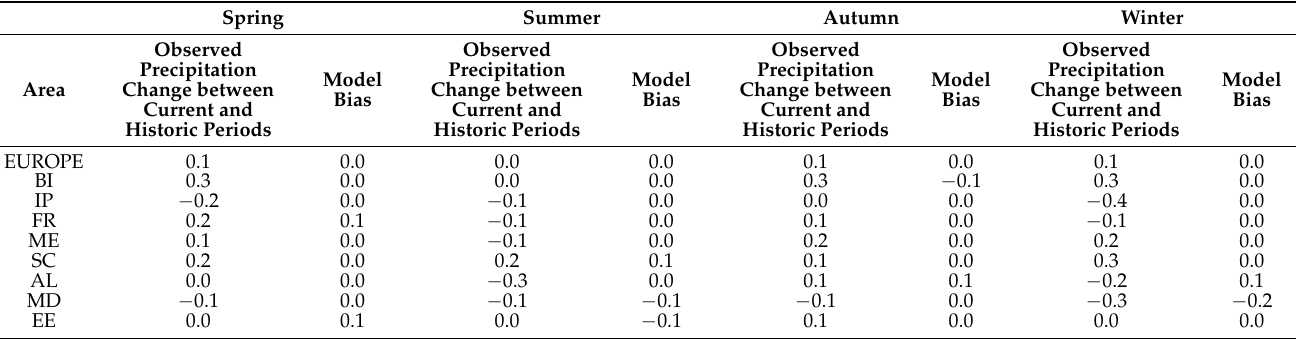
Table 5. Same as Table 4 but for each season